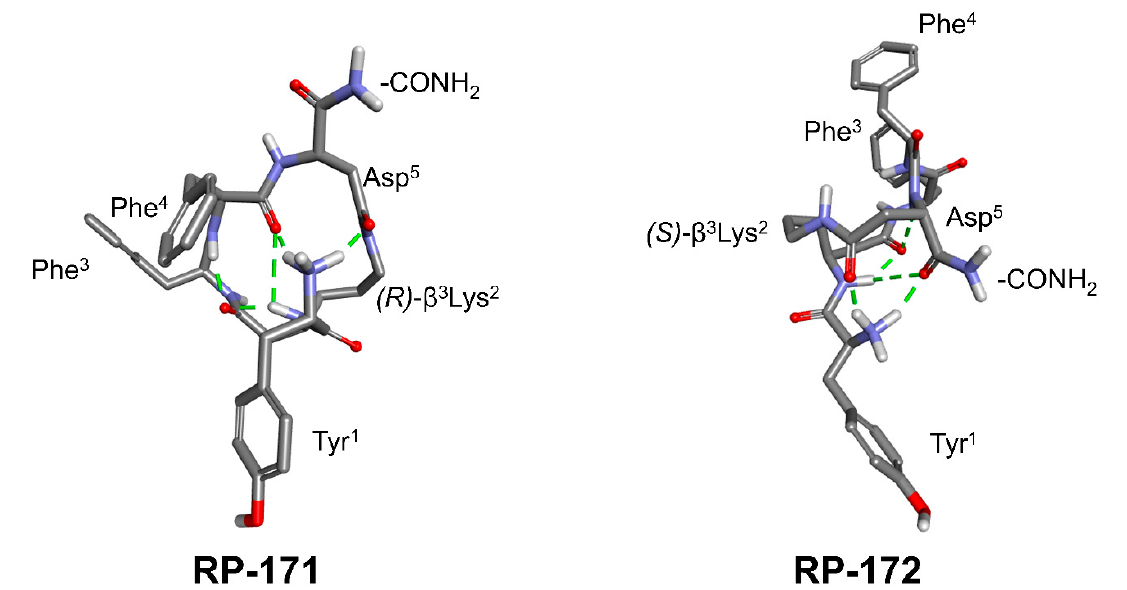
Figure 3. The lowest-lying conformers of RP-171 and RP-172 (at the B3LYP/6-31G(d,p) in the gas phase. Green dots show intramolecular hydrogen bonding.